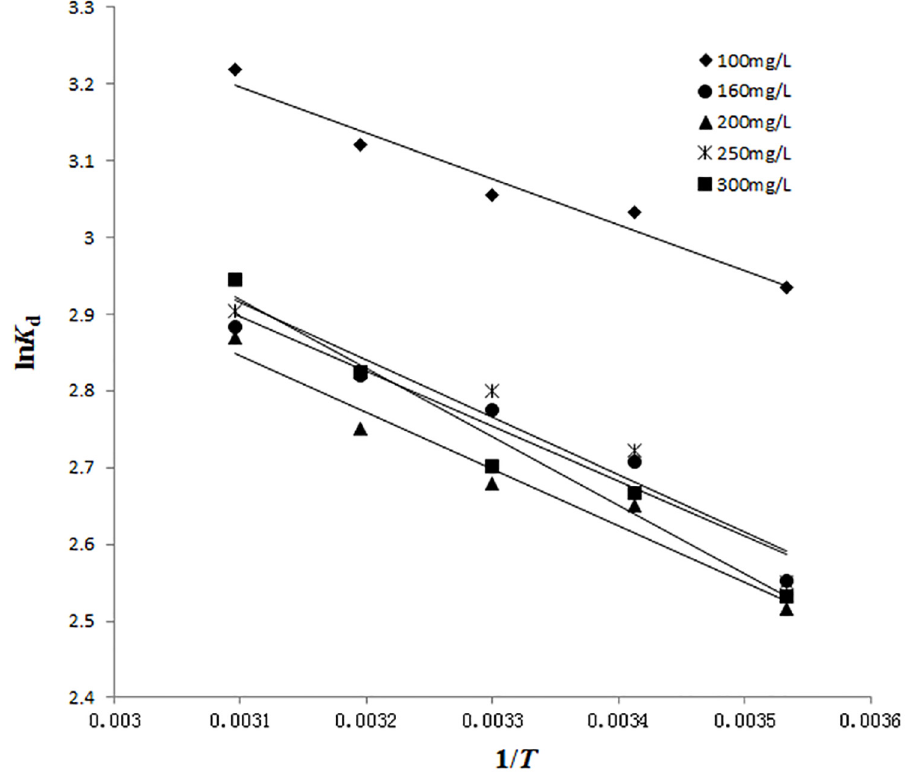
Fig 8. The plots of ln K d versus 1/ T at various initial concentrations. (experimental conditions: pH = 5 and c 0 = 100~300